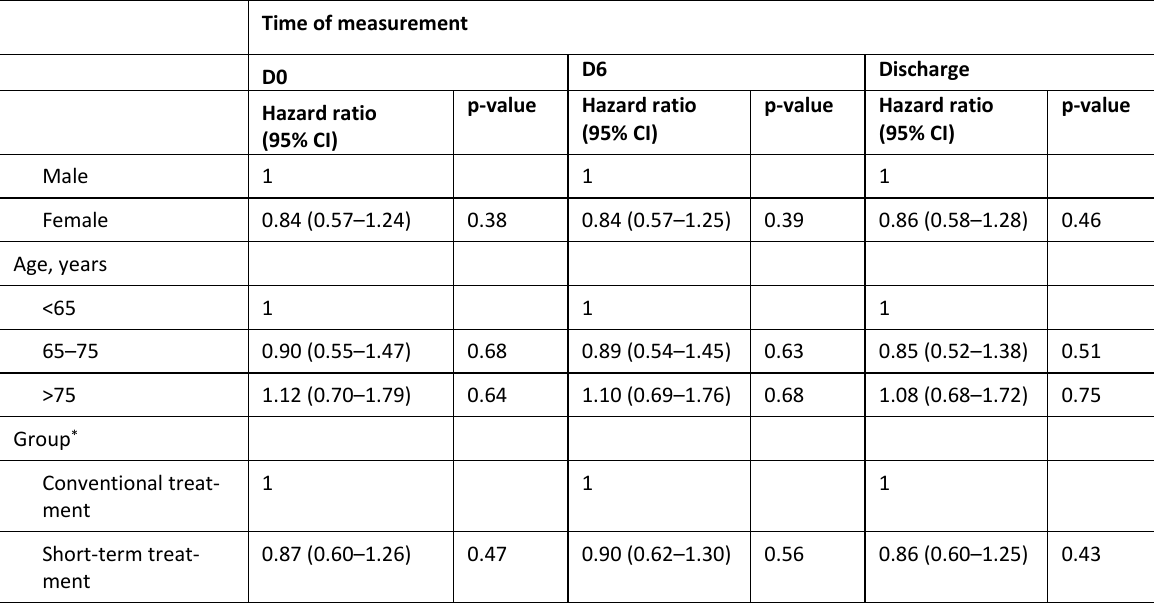
Table 4: Multivariate analyses of predictor variables of time to re-exacerbation and/or